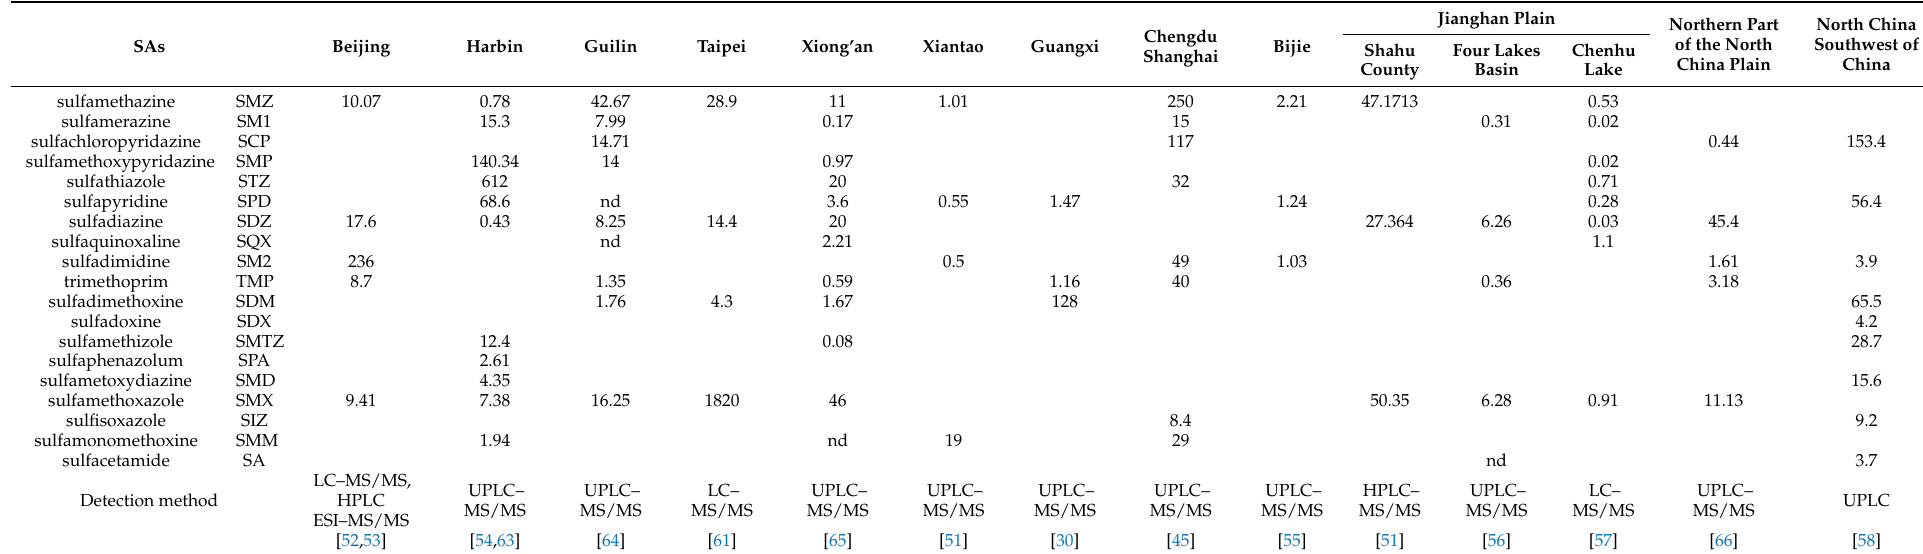
Table 2. SAs and their concentrations detected in groundwater of China (ng/L), and the detection